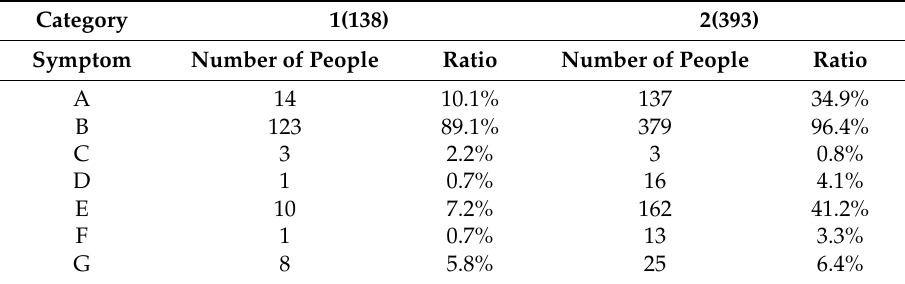
Table 5. Symptom